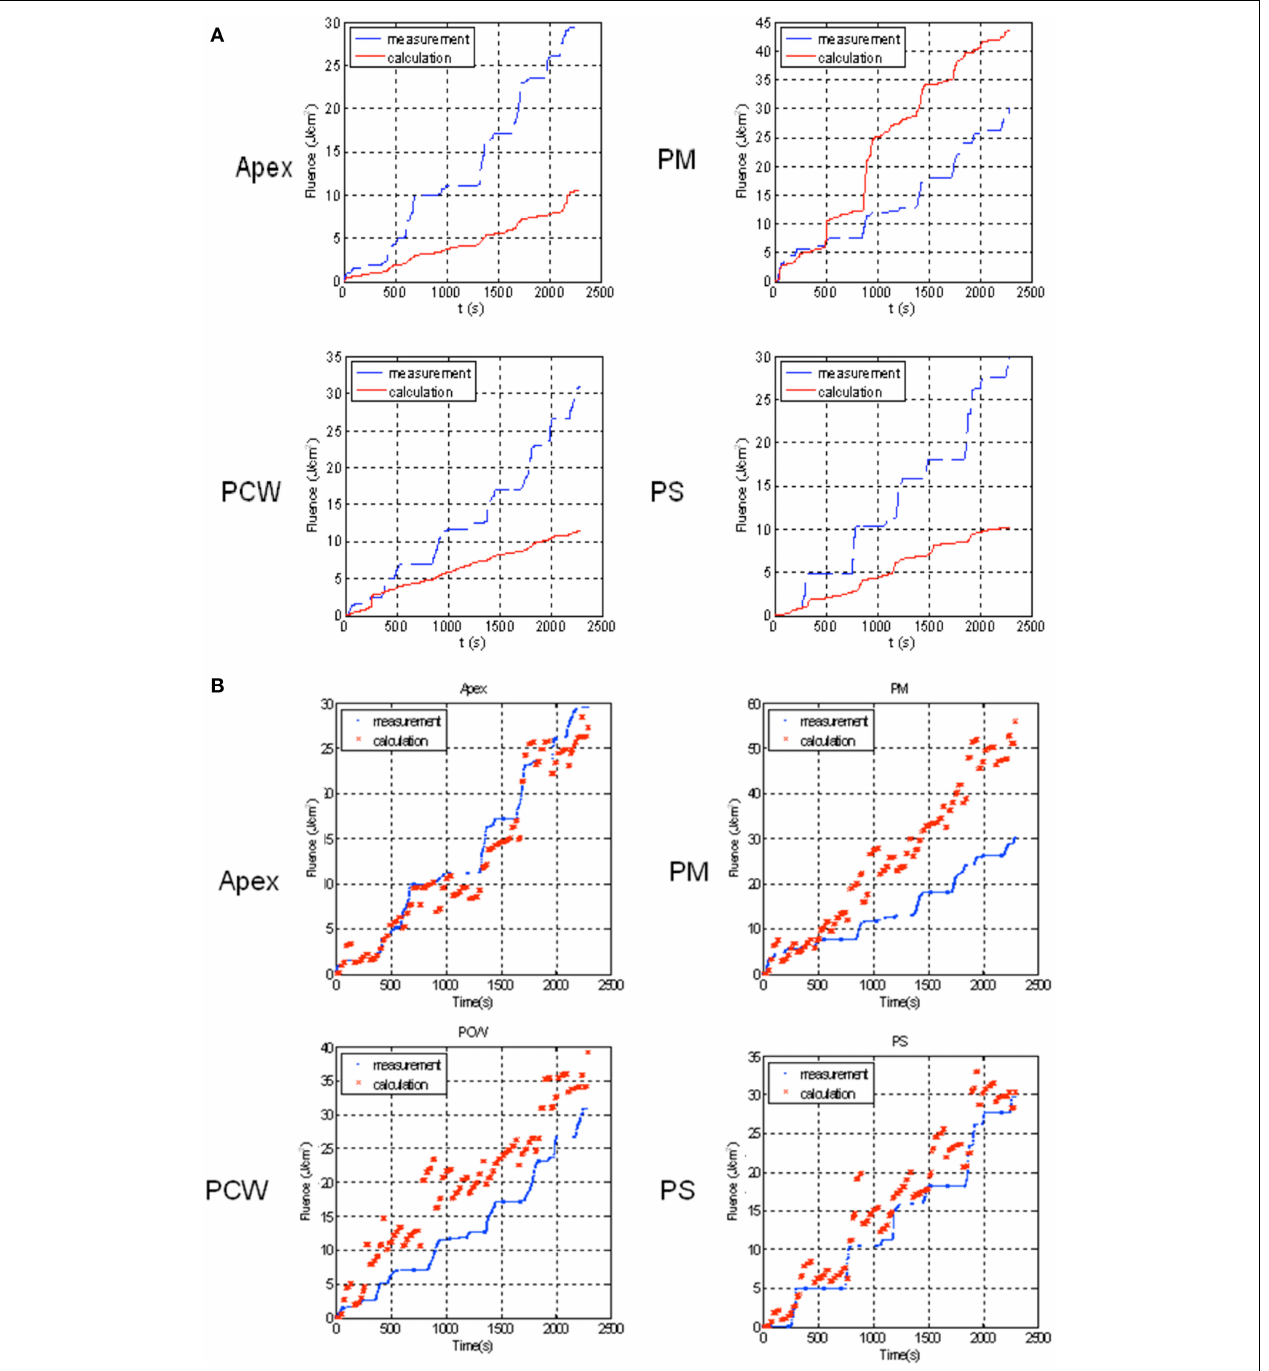
FIGURE 10 | Comparison of measurement (blue) and uncorrected calculation using (A) direct light only (Equation 6) (red) and (B) corrected light fluence rate (Equation 9) for patient for 4 detector locations: Apex, PM (posterior mediastinum), PCW (posterior chest wall), PS (posterior sulcus).